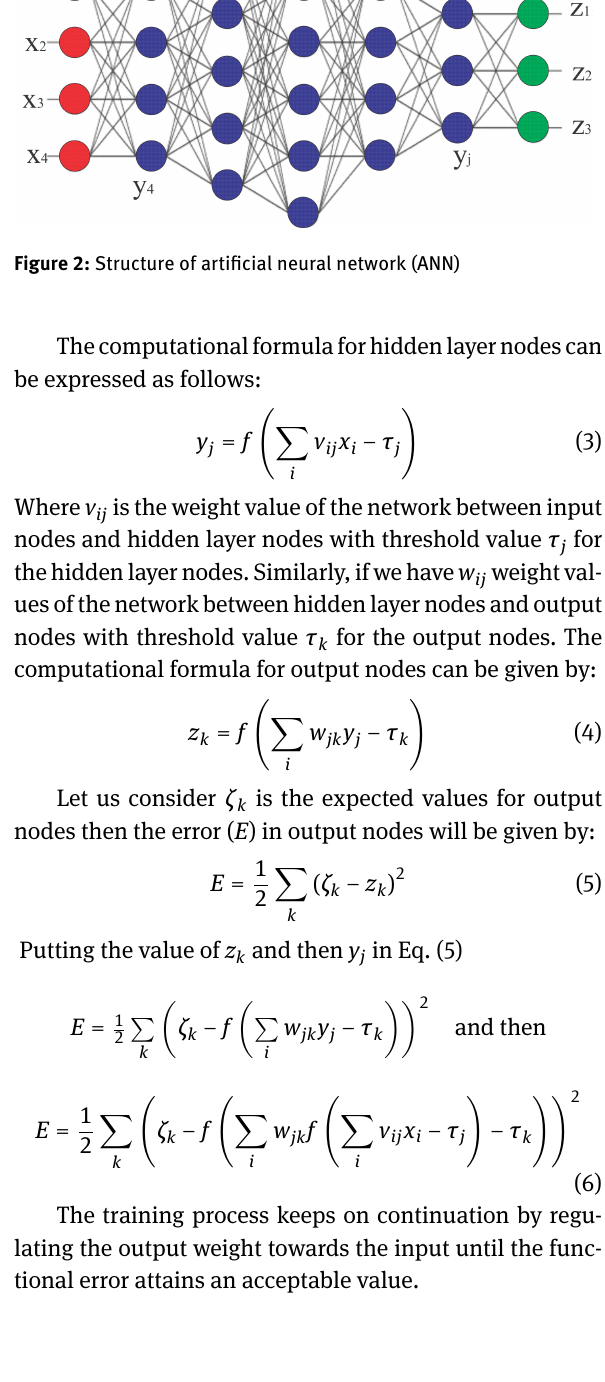
Figure 1: Location of GPS sites in WGS-84 coordinate system